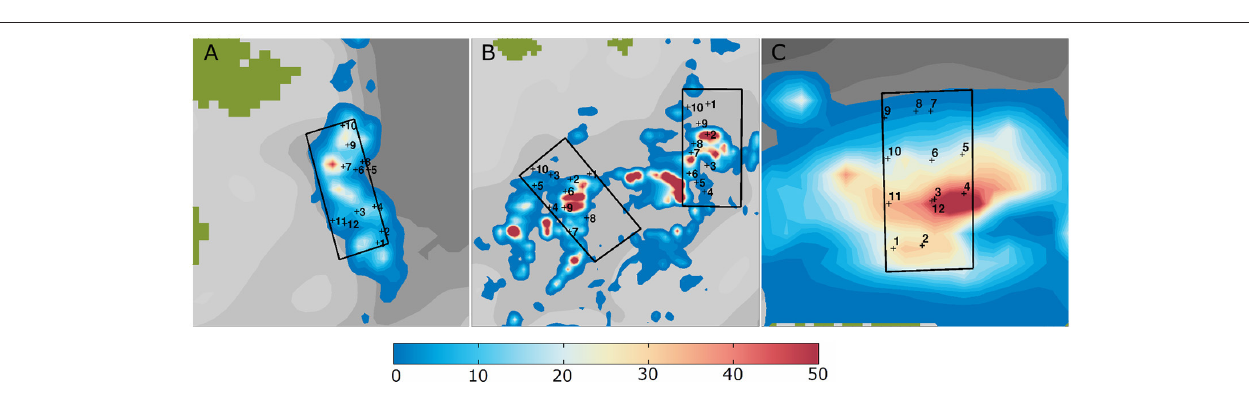
FIGURE 8 | Magnification of the corresponding panels in Figures 7A–C , from the simulations with resuspension at location 1 (A) , location 2 (B) , and location 3 (C) . The numbers in the plot correspond to the MOM samples presented in Figure 10 . The colors indicate mud thickness (mm). The shade of gray indicate bottom depth.